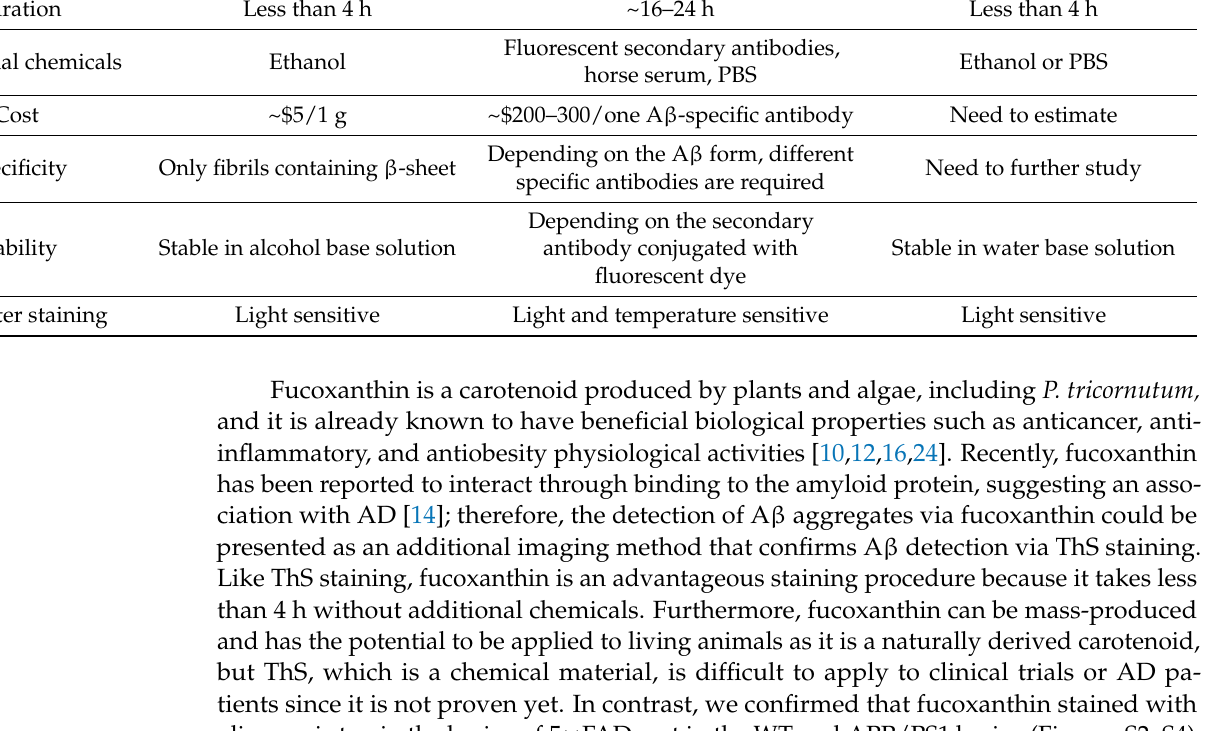
Figure S3: Histochemical analysis of the brains in 5XFAD mice after staining with fucoxanthin (Fx) and anti-oligomeric tau antibody. Figure S4: Histochemical analysis of the brains in APP-PS1 mice after staining with fucoxanthin (Fx) and anti-oligomeric tau